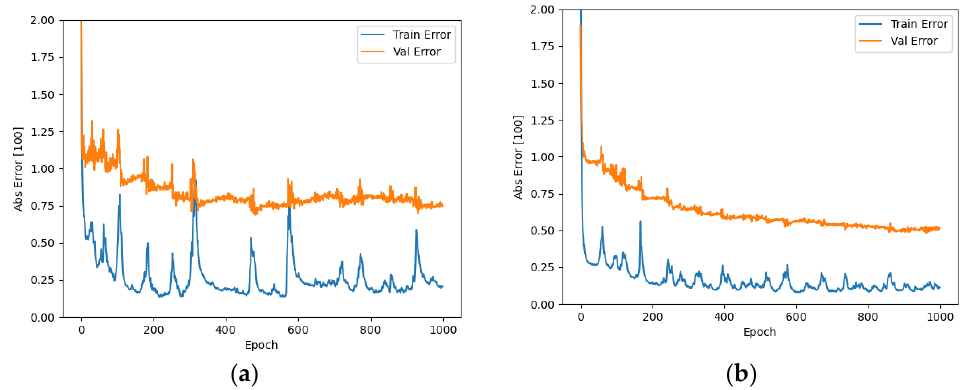
Figure 9. Training set and validation set error (absolute error): ( a ) 3 s training set and validation set error; ( b ) 10 s training set and validation set error.